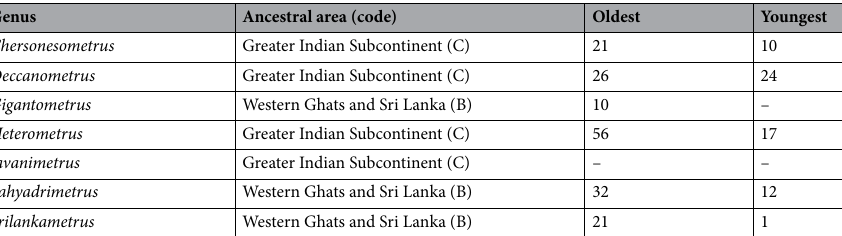
Table 2. Ancestral areas of each genus of Asian forest scorpions (Scorpionidae: Heterometrinae) recovered by DEC + j analysis, with oldest and youngest divergence dates (millions of years) within each genus recovered by divergence time estimation analysis.